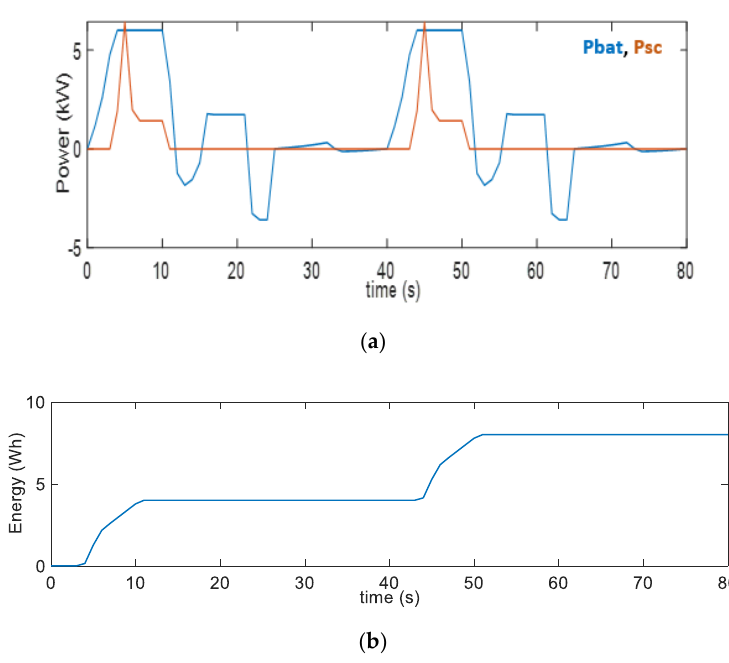
Figure 9. ( a ) Battery power limitation without supercapacitor energy supervision (battery power in blue, supercapacitor power in red). ( b ) Supercapacitor energy.